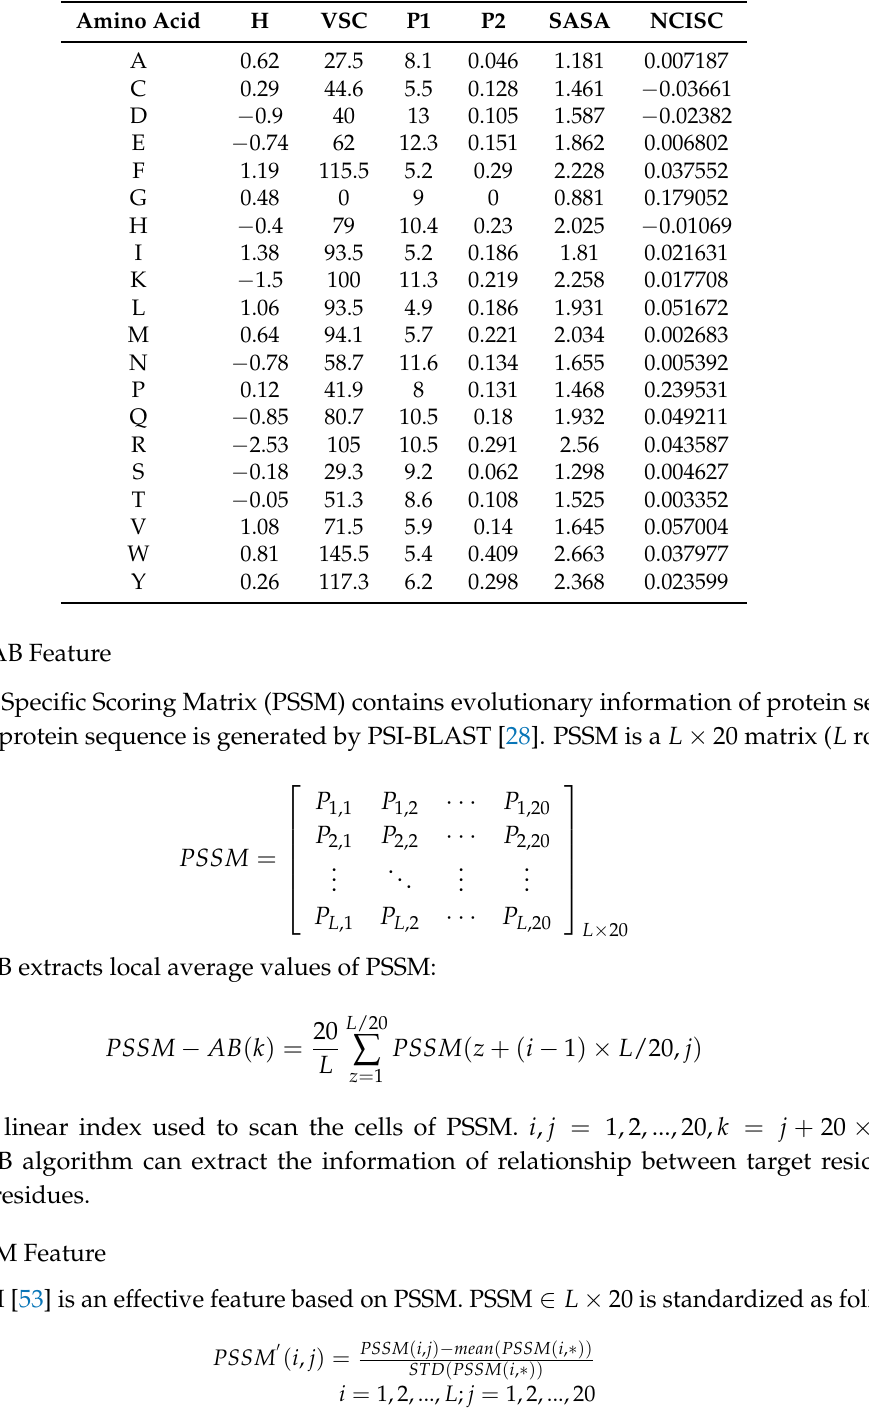
Table 5. The values of the 6 properties for twenty amino